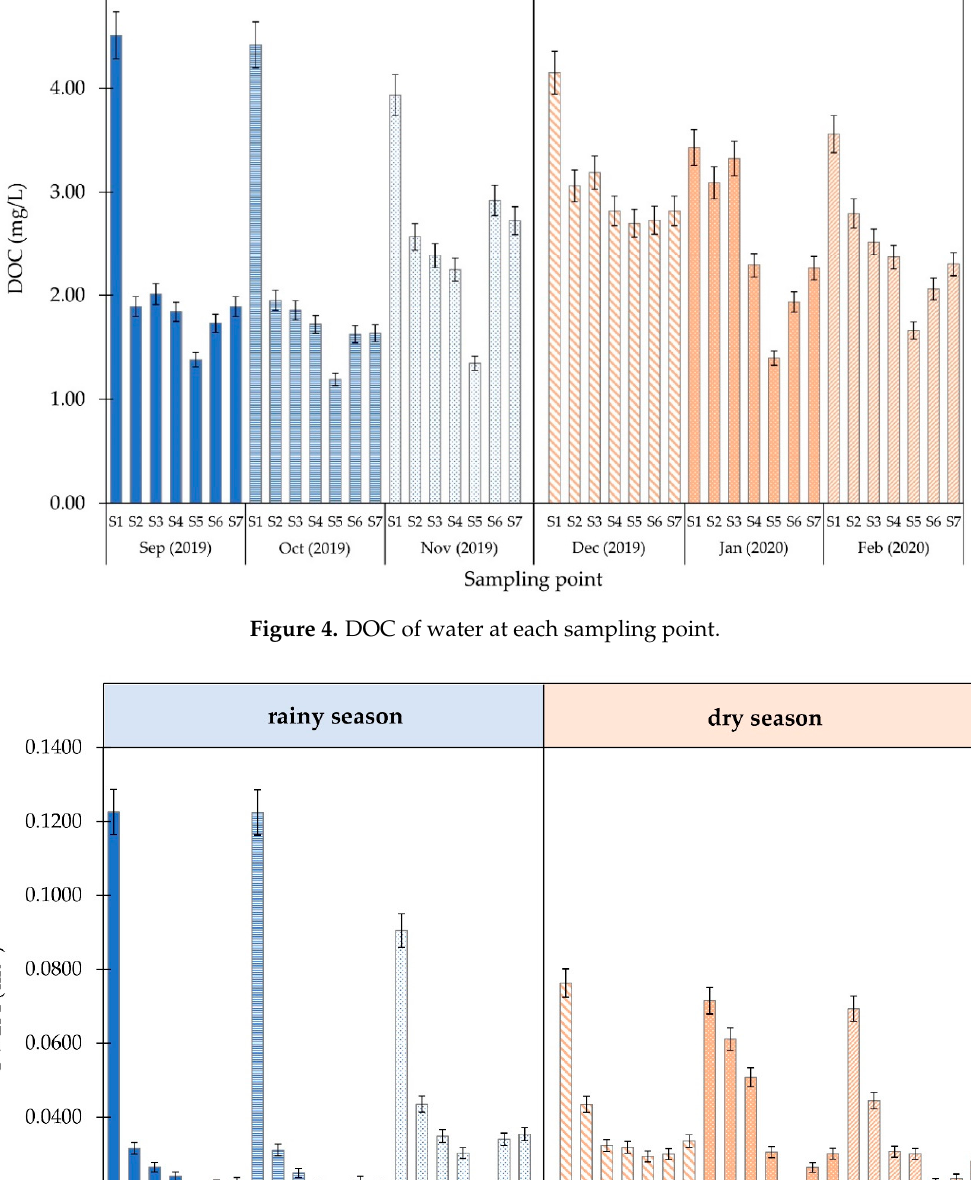
Figure 3. Alkalinity of water at each sampling point.